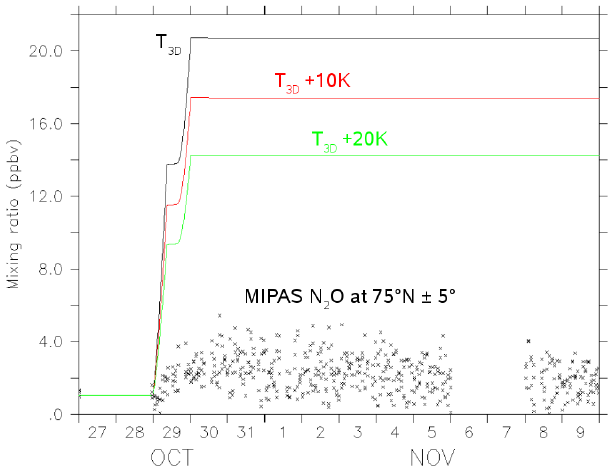
Fig. 7. Mixing ratios of N 2 O at 60km, 75 ◦ N from the CAABA box model at three different temperatures (lines), and MIPAS N 2 O measurements for the same latitude